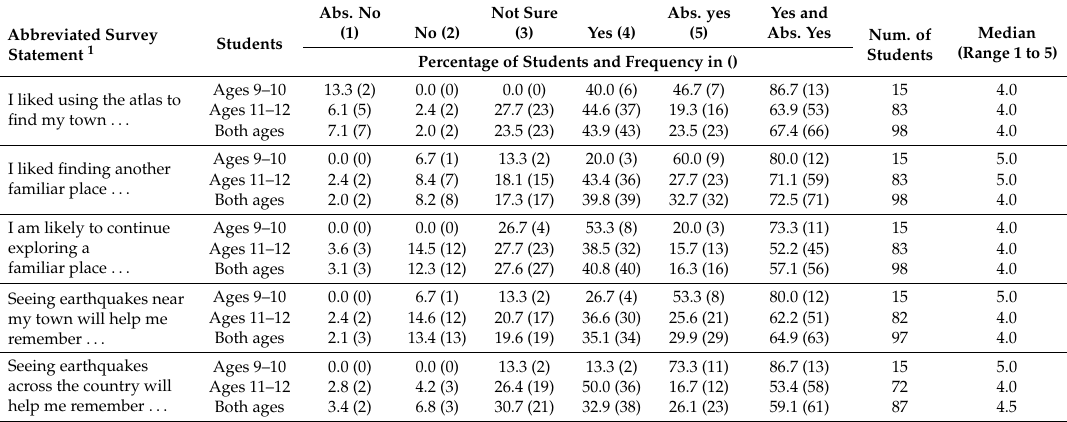
Table 3. Responses of students ages 9–10 and 11–12 to statements related to local and familiar context and broader national or global